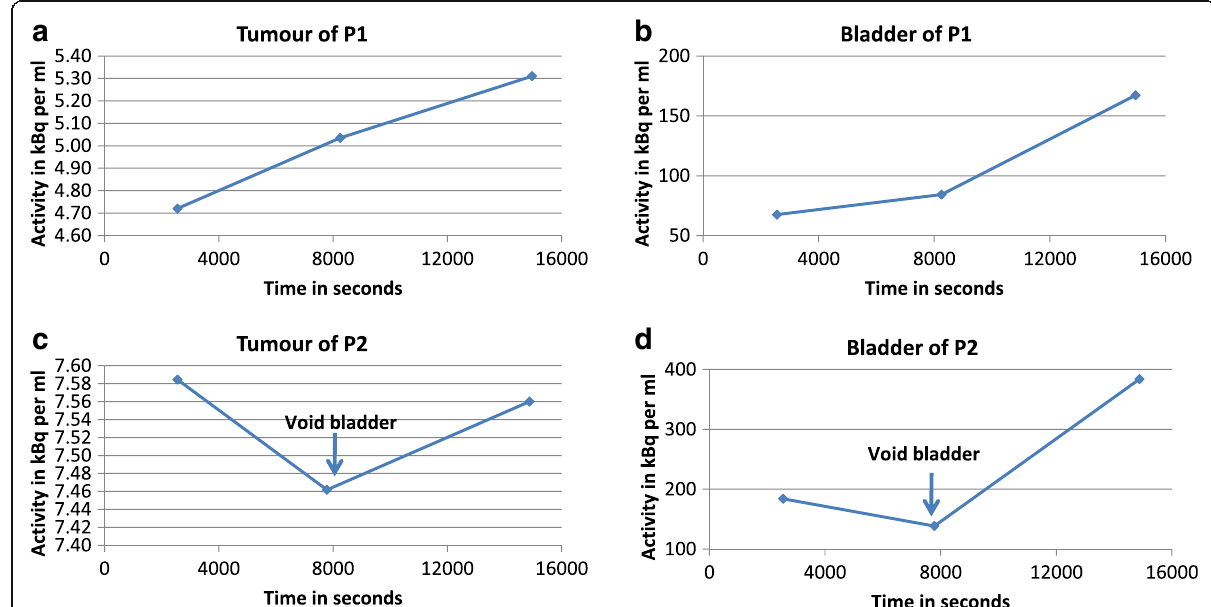
Fig. 5 Examples from non-enema group showing TAC at 45 min, 2 and 4 h PET from tumour ( a , c ) and bladder ( b , d ). The TACs in a and b corresponds to patient 1 (P1) in Fig. 4 a – c and the TACs in c and d correspond to patient 2 (P2) in Fig. 4 d – f . The TACs show the effect of changes in bladder activity on apparent tumour activity at each time point. Although patient 2 emptied their bladder before the 2 h scan, the activity accumulated again at 4 h and consequently the activities in both bladder and tumour first dropped at 2 h (compared to 45 min) and then increased again at 4 h (compared to 2 h). This shows the effect of changes in bladder (and possibly non-tumour) activity on tumour TAC. TAC = time-activity curve; min = minutes; h = hour; PET = positron emission tomography; ml = millilitre; 1 millilitre = 1 cm 3 kBq = kilo